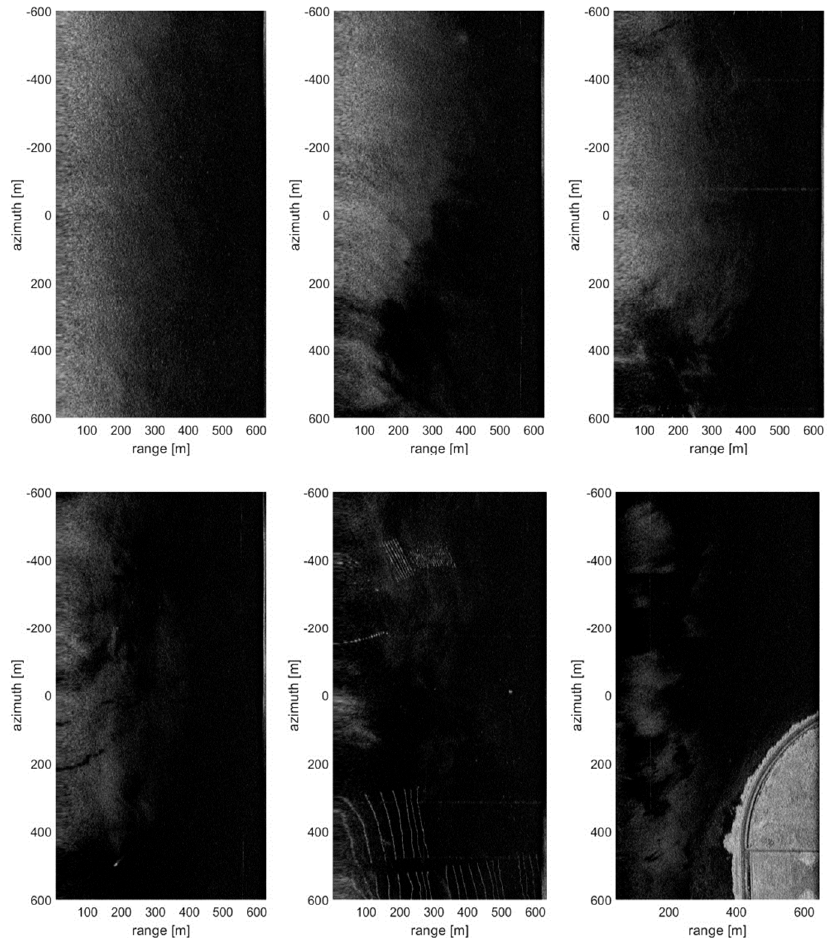
Figure 13. Examples of the reconstructed SAR image for ocean monitoring: upper images show bare sea surfaces without any target, whereas lower images include various targets such as a small ship, sea farm buoys, and shoreline.